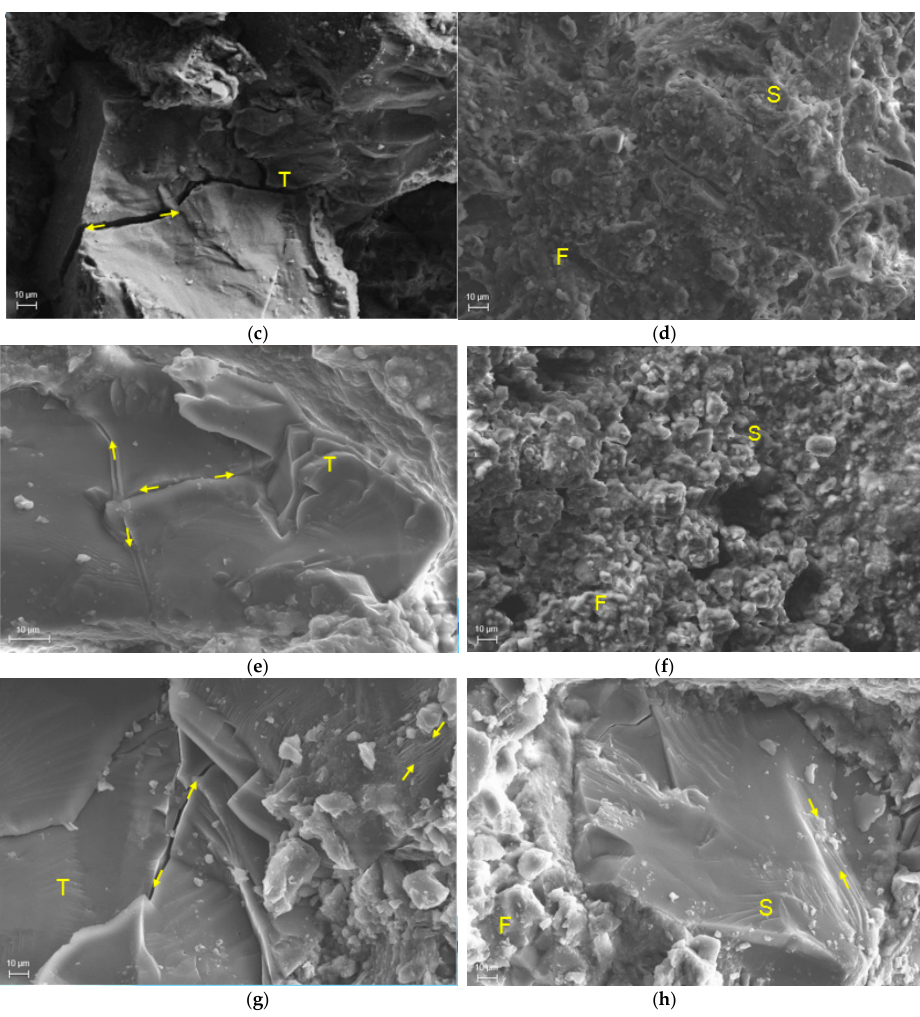
Figure 8. Typical SEM images of sandstone fractures with the initial confining pressure 10 and 40 MPa in unloading confining pressure tests: ( a , b ) TC-D-10; ( c , d ) TC-S-10; ( e , f ) TC-D-40; ( g , h ) TC-S-40 (Opposite arrows and inverse arrows represent slip trace and tensile trace respectively; and the letters F, S and T represent fragments, shear crack and tensile crack, respectively).